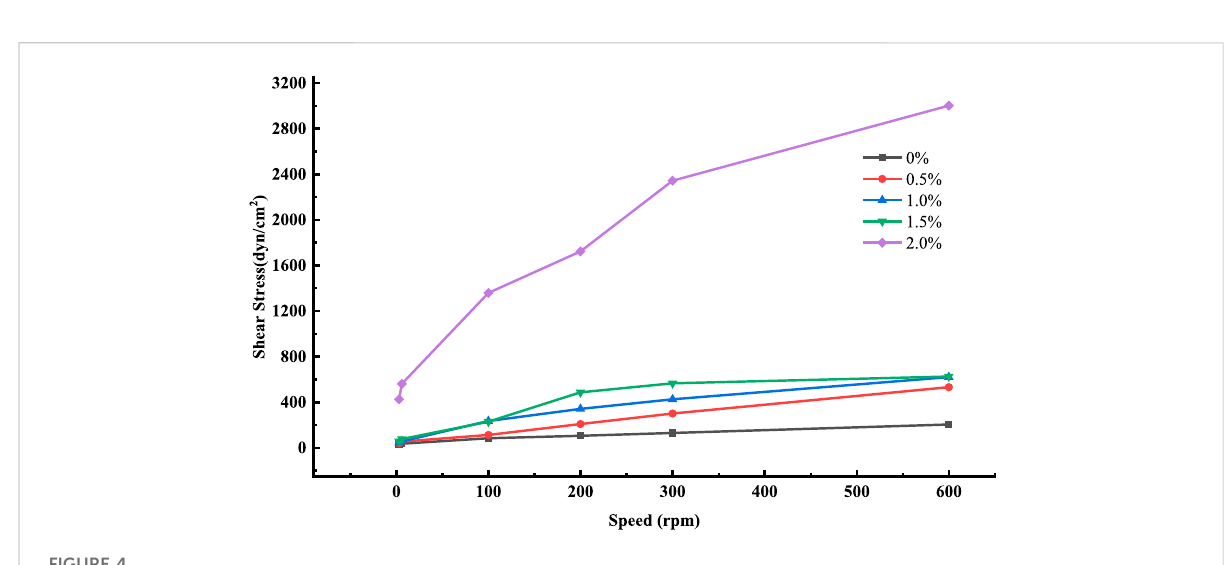
FIGURE 4 Comparison of shearing stress at different rotating speeds under different concentrations of